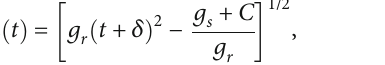
= 0 . (b) The classical r = 0 c